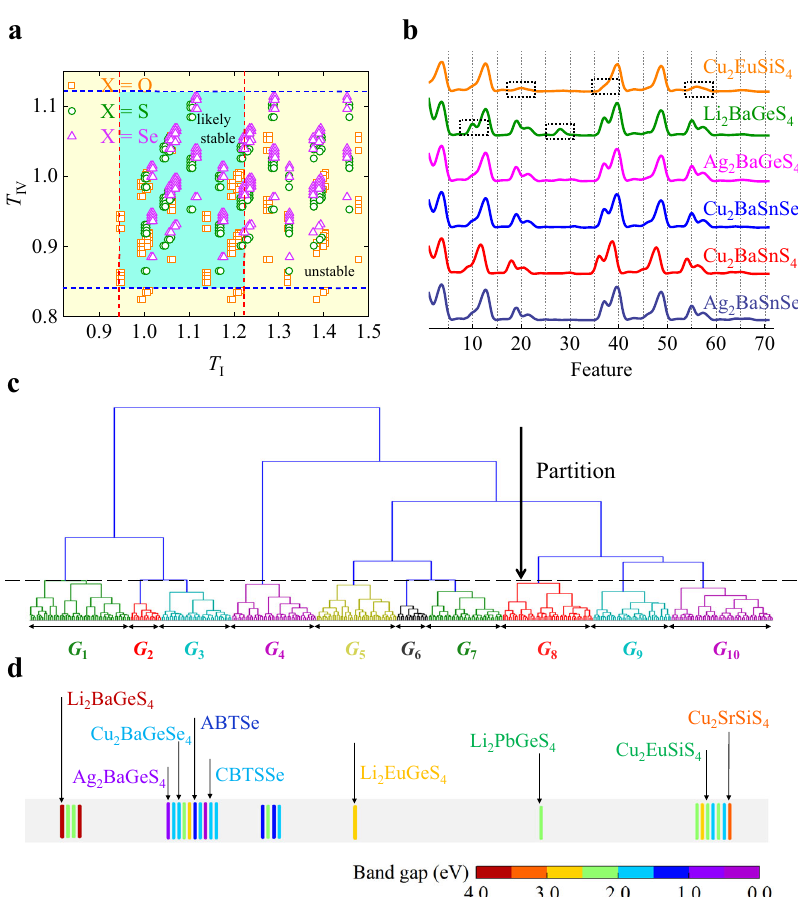
Fig. 2 Unsupervised learning of I 2 -II-IV-X 4 semiconductors. a Plot of tolerance factors ( T I and T IV ) of 675 I 2 -II-IV-X 4 compounds, where 380 likely stable compounds are in the cyan area. b Computed features of six selected compounds based on SDEPs, dotted boxes show signi fi cant differences in features. c Bottom-up tree diagram (dendrogram) generated by the agglomerative hierarchical clustering (AHC) method. The dashed line shows the position where all compounds are partitioned into ten groups, marked as G 1 – G 10 from left to right and distinguished by different colors. d Mapping the dendrogram to the band gaps, revealing the grouping of 27 known I 2 -II-IV-X 4 semiconductors (Supplementary Table 1). The color bar shows the scale of band